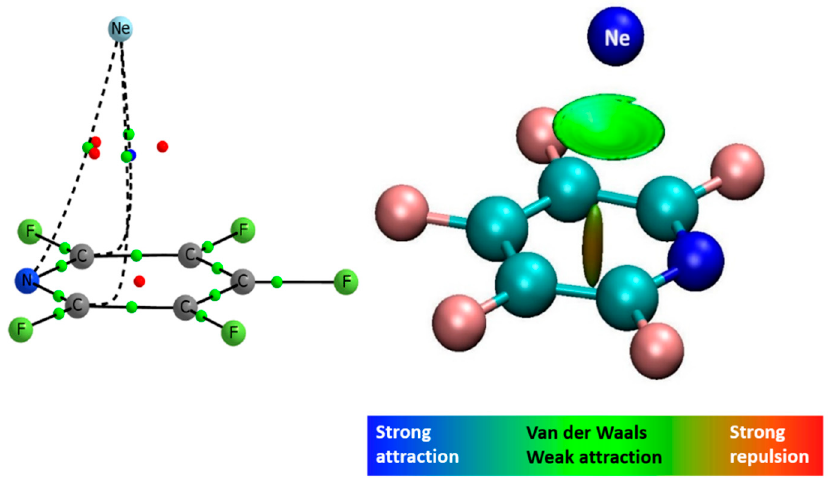
Figure 4. Molecular graph showing three bond critical points (left) and NCIPlot (right) of the F 5 PY-Ne complex.